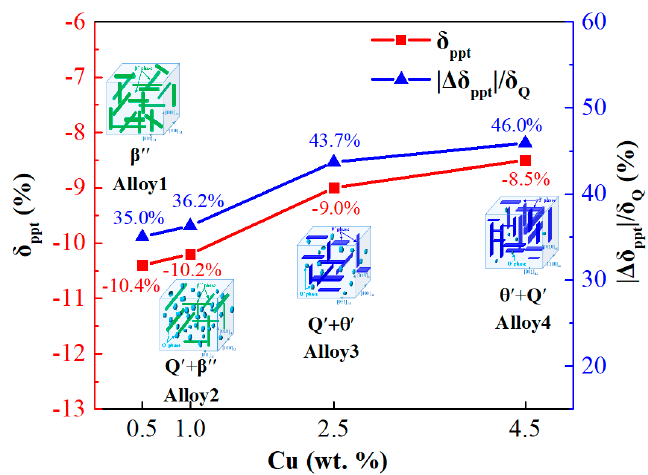
Figure 24. Influence of precipitation on the elongation of the Figure 24. I nfluence of precipitation on the elongation of the alloy.